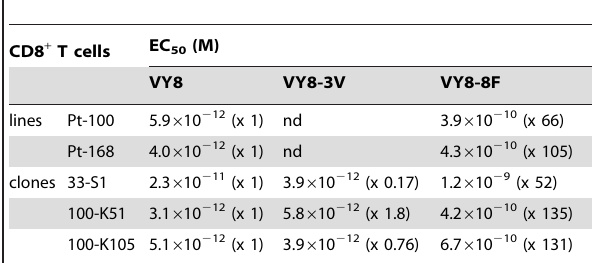
Table 3. Sensitivity of VY8-specific CD8 + T